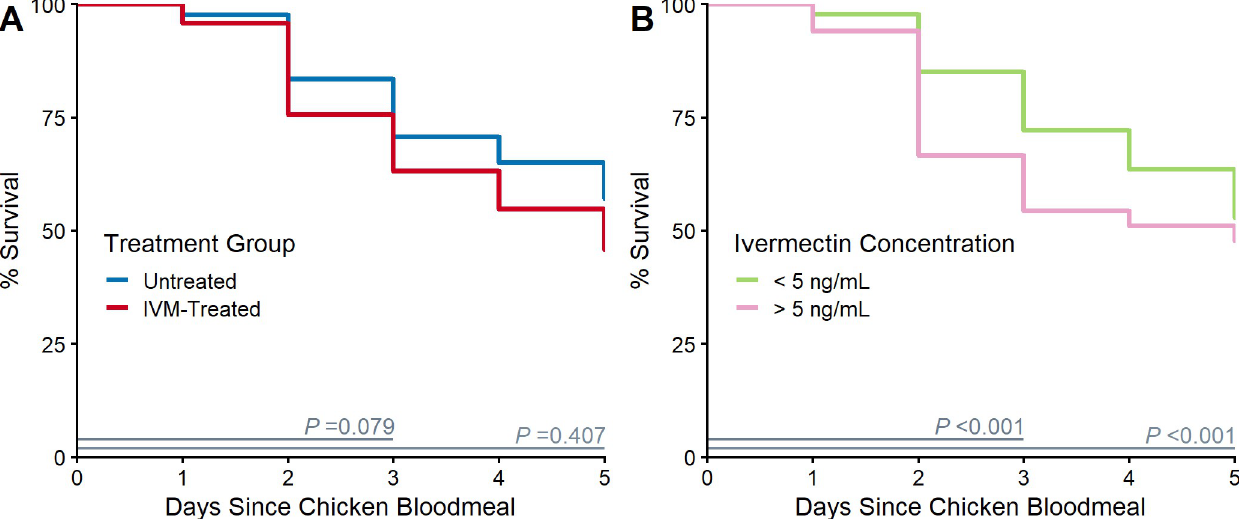
Fig 5. Blood feeding on ivermectin (IVM)-treated chickens increased wild Culex tarsalis mortality. Wild-caught Cx . tarsalis survival following blood feeding on a randomly chosen chicken from each coop A) by treatment group and B) stratified by IVM serum concentration above or below the limit of quantification (LOQ, 5 ng/mL). Mantel-Haenszel chi-square P -value indicated for comparison of Kaplan-Meier survival curves for 1–3 and 1–5 days (duration indicated by grey segment). IVM-related effects were expected to occur within 3 days post-bloodmeal.